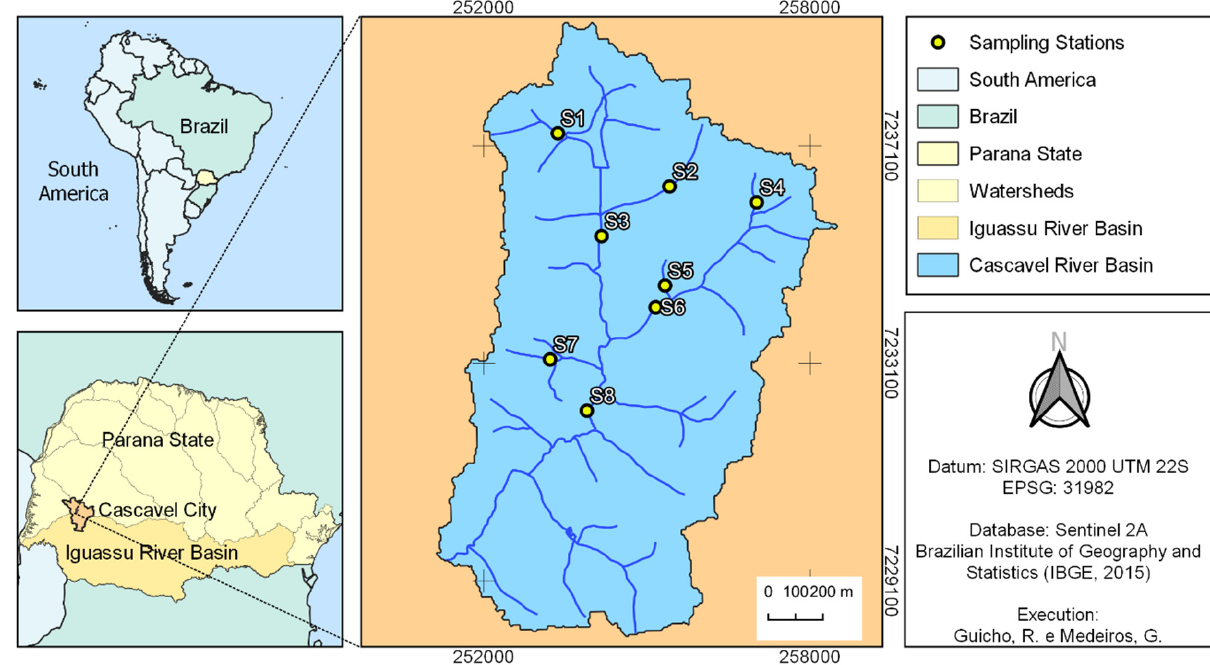
Figure 1. Location of sampling stations (S) in Cascavel River micro-watershed, Cascavel City—PR, Brazil.